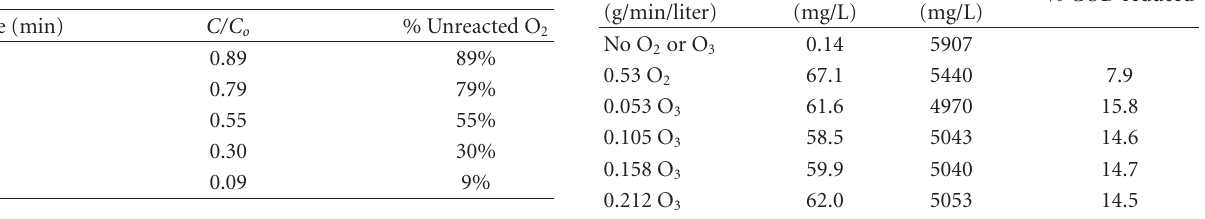
Figure 1: O 3 /O 2 aerosol bubble injection contact chamber. Table 2: Kinetics of first-order reaction with k = 0.12/min.